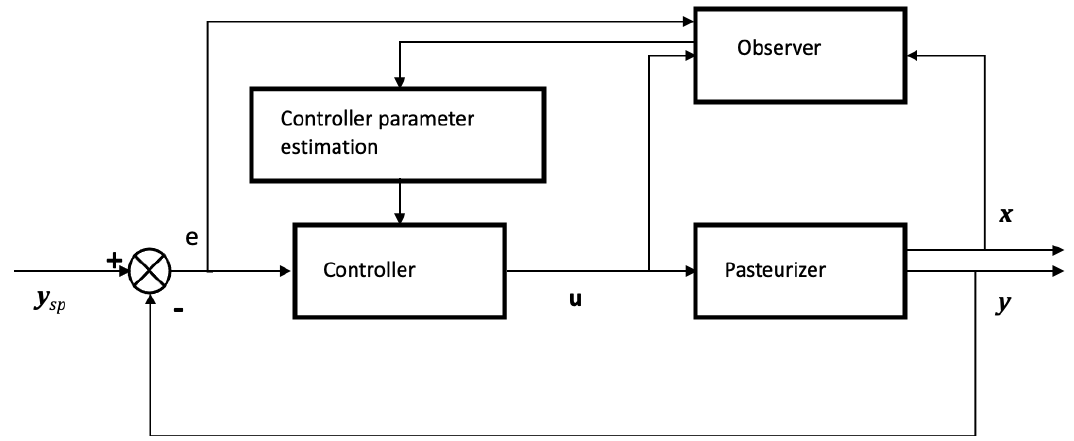
Figure 2. Block diagram of the adaptive control scheme.